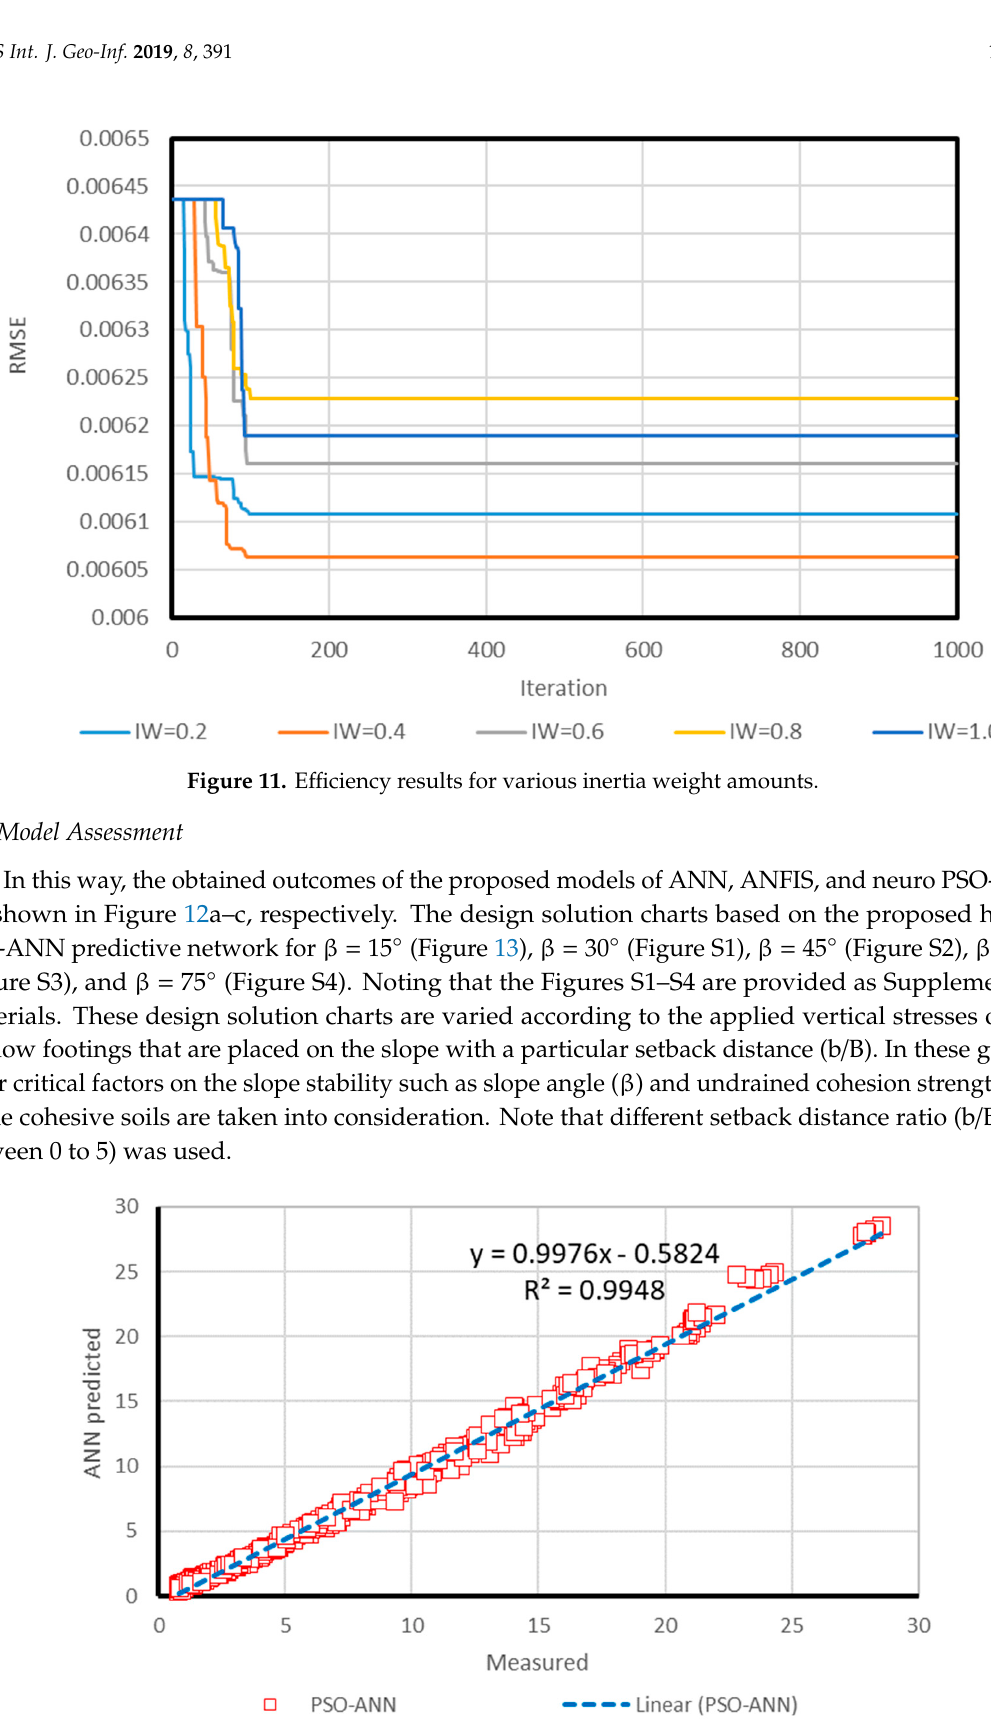
( a ) ANN model in predicting factor of safety (ANN with six nodes). Figure 12. Cont